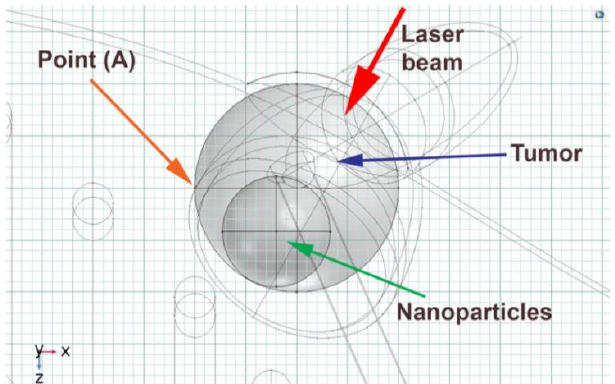
Figure 2. Position of the tumor, the area doped with nanoparticles and the point (A) of calculations at the x - z plane. The laser beam direction is also noted.